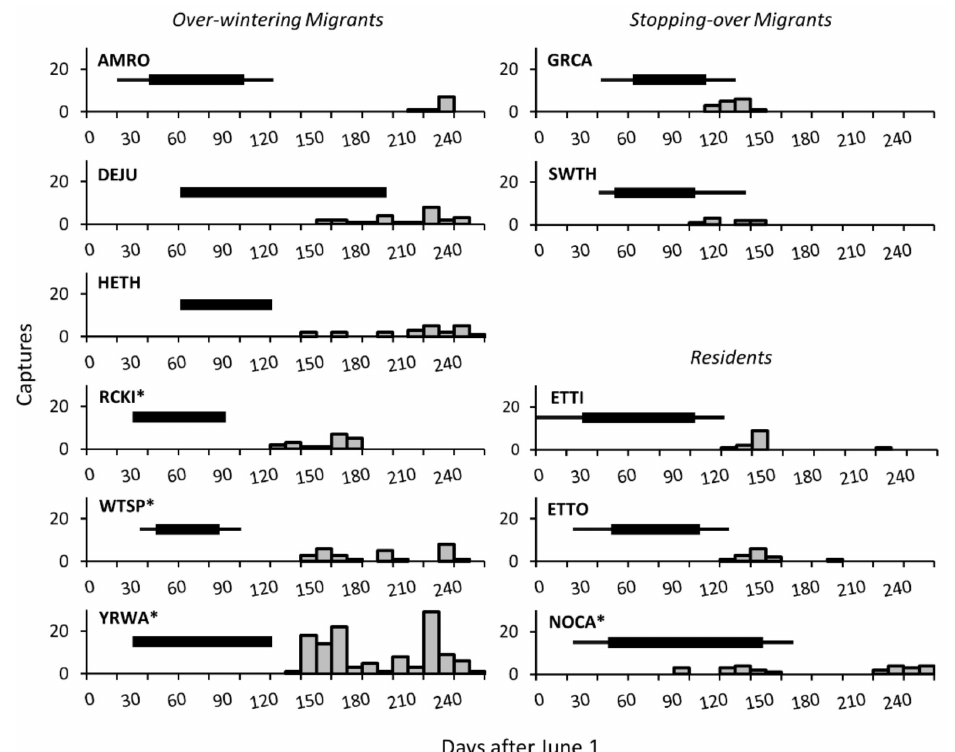
Figure 1. The timing of captures and molt for songbird species used in this study. Histograms indicate the numbers of birds from whom tail feathers and/or blood samples were collected over time between June and January. Heavy black bars depict the period in which a majority of individuals for a given species molt their flight feathers, with narrow bars indicating infrequent observations of flight feather molt. Molt data are taken from [42–52]. Species are grouped by life history (over- wintering migrant, stopping-over migrant, or resident) and asterisks denote species with sufficient sample sizes for quantitative comparisons between fall and winter diets. Species codes: AMRO = American Robin; DEJU = Dark-Eyed Junco; EATO = Eastern Towhee; ETTI = Tufted Titmouse; GRCA = Gray Catbird; HETH = Hermit Thrush; NOCA = Northern Cardinal; RCKI = Ruby-Crowned Kinglet; and SWTH = Swainson’s Thrush; WTSP = White-Throated Sparrow; and YRWA =